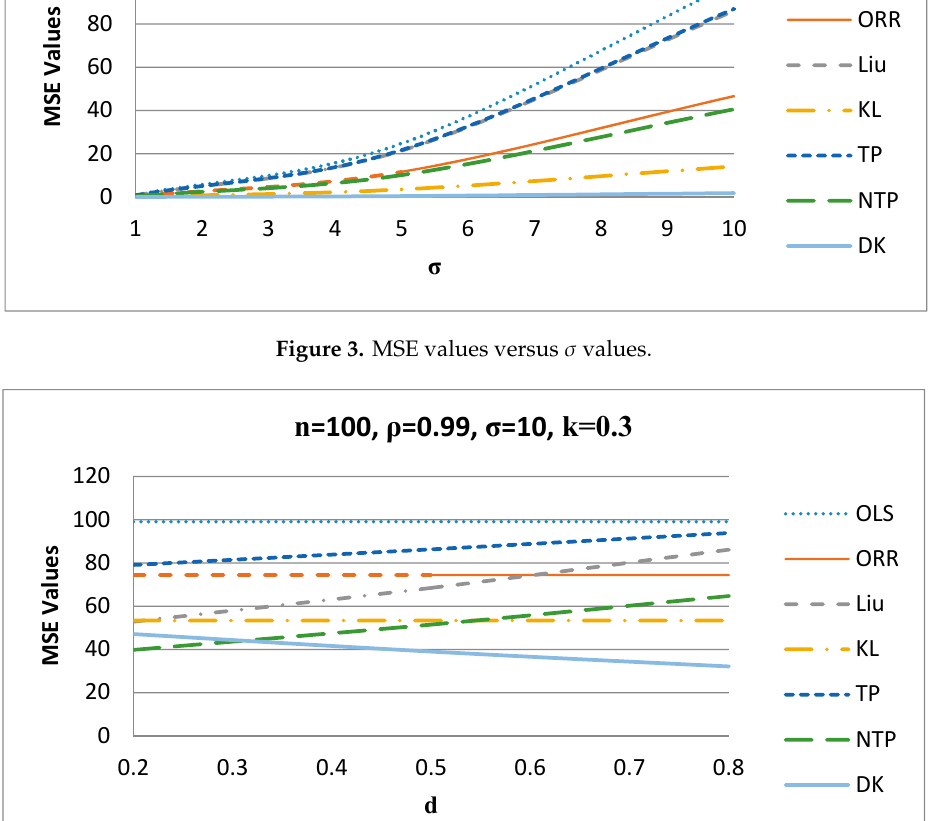
Figure 4. MSE values versus d values when k =